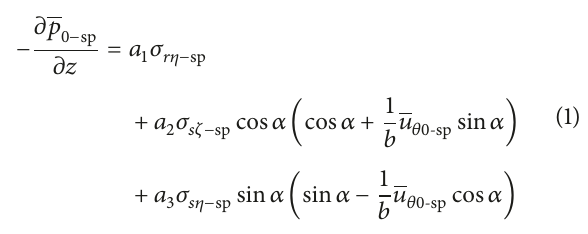
Figure 1: Schematic of a liquid annular seal with herringbone grooves on the stator.